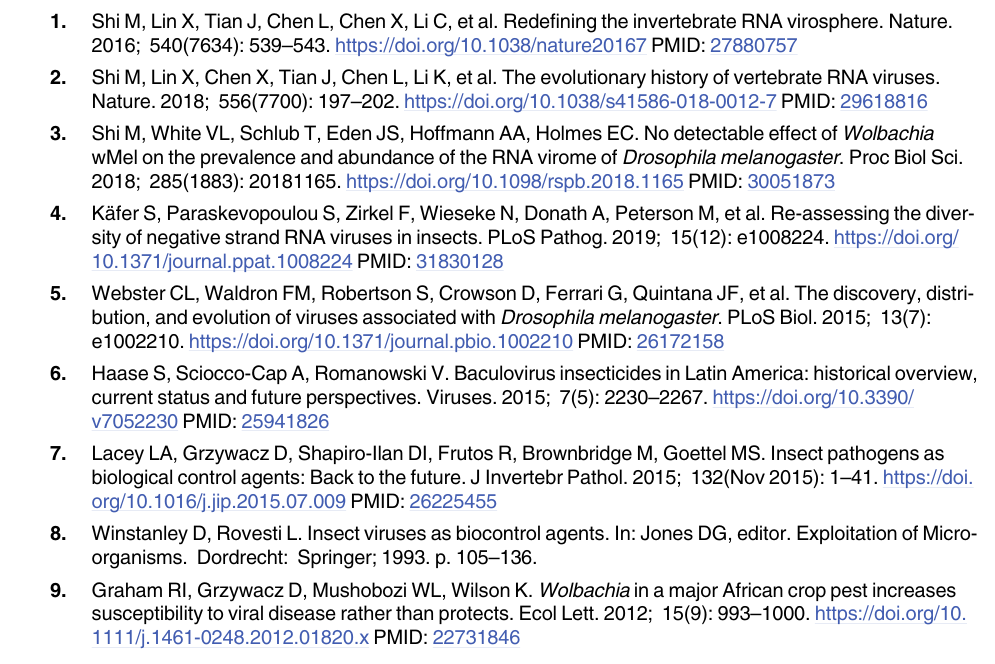
S9 Data. The original data used in Fig 5 and Fig 6. The data from RNA-seq using samples from the two Spodoptera species, include the TPM values of significantly expressed Genes for Fig 5A and 5C, Fig 6A–6E and p values of pathways selected for Fig 5B and 5D. (XLSX) S10 Data. The significantly enriched pathways in the two Spodoptera species.